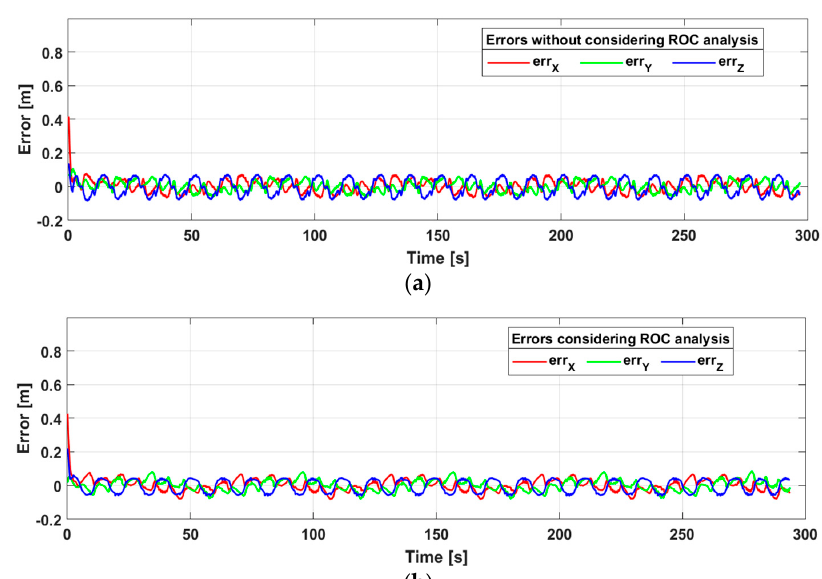
Figure 9. Errors in each of the axes ( a ) without considering ROC (radius of curvature) analysis, ( b ) considering ROC analysis.